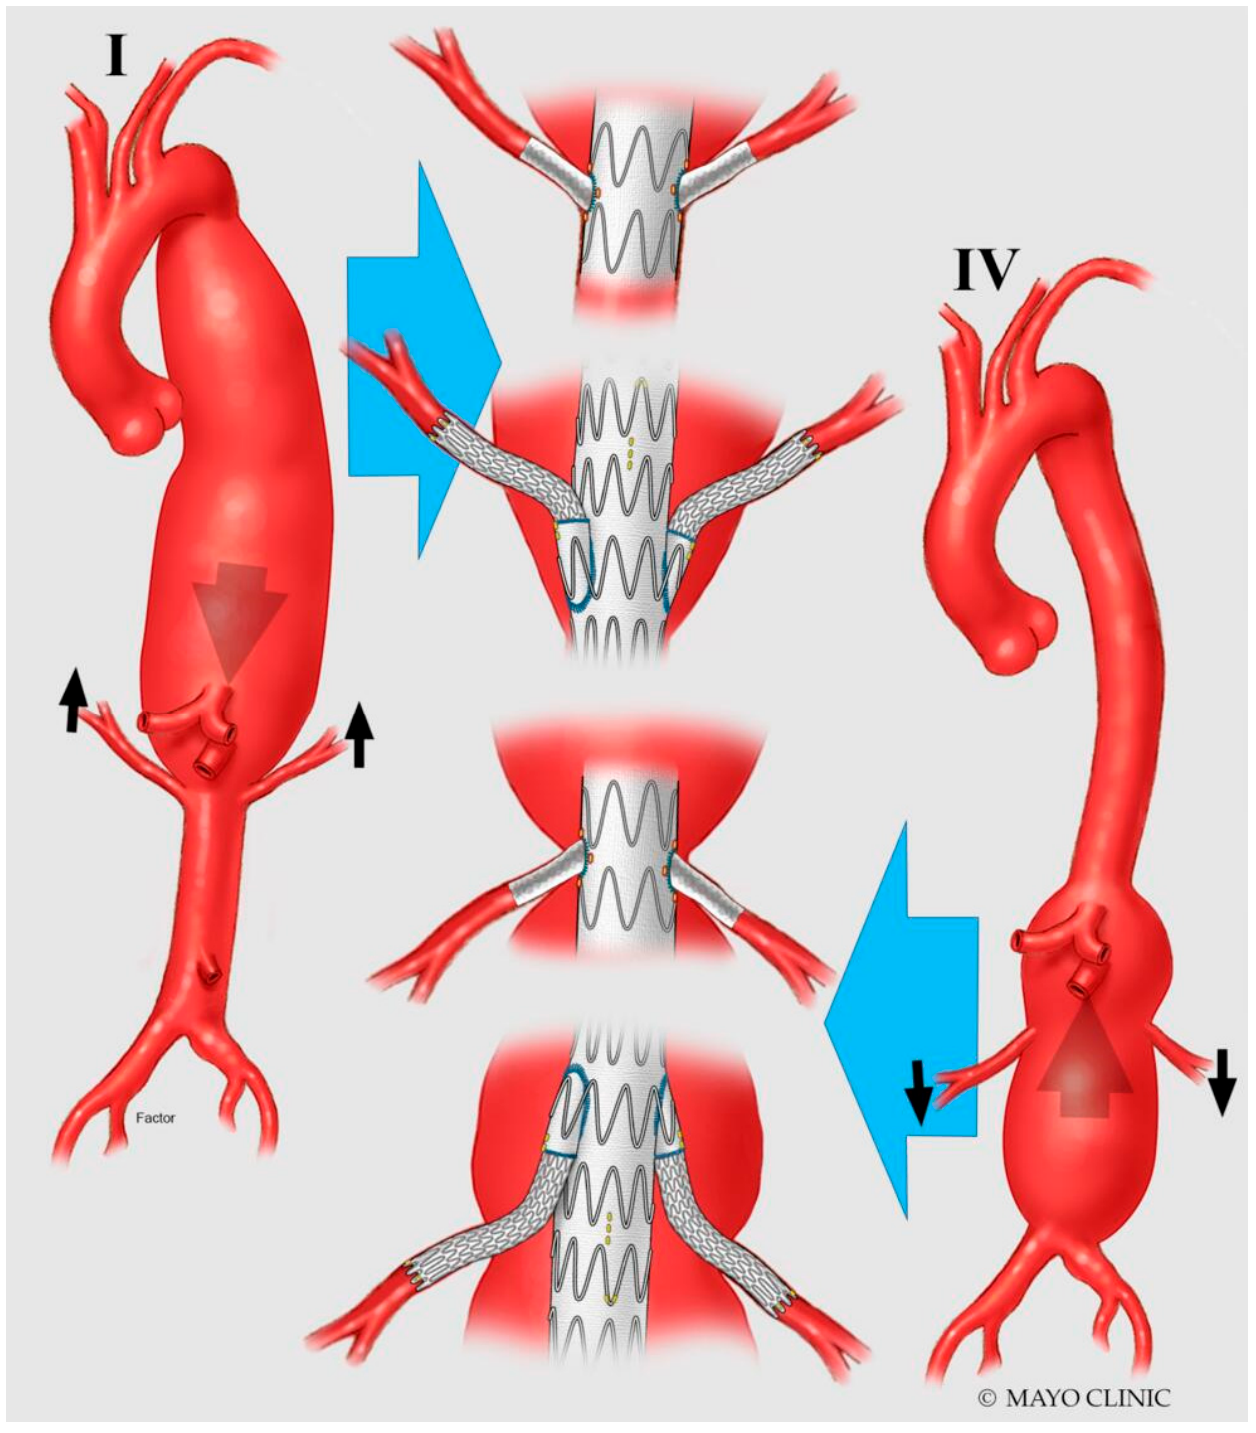
Figure 2. Technical solutions with different configurations (upward outer branches, inner branches, downward outer branches) for incorporation of renal arteries during BEVAR. I: complex AAA with upward orientation of renal arteries; IV: complex AAA with downward orientation of renal arteries